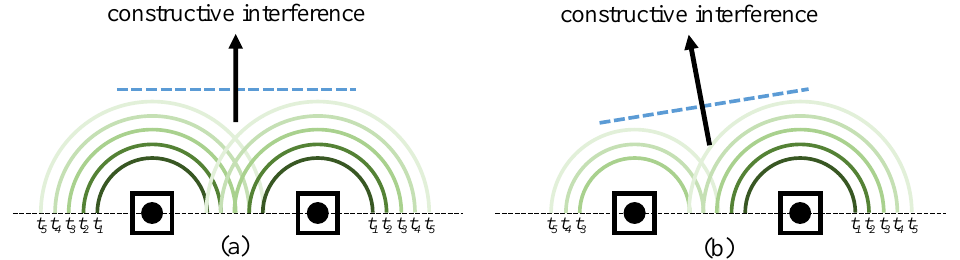
Figure 1. Different beamforming directions for two radiators with different time delays. In ( a ), two radiators emit the same signal at the same time. In ( b ), two radiators also emit the same signal, but the left one starts from t 3 , inducing a different constructive interference compared with ( a ), thereby a left direction